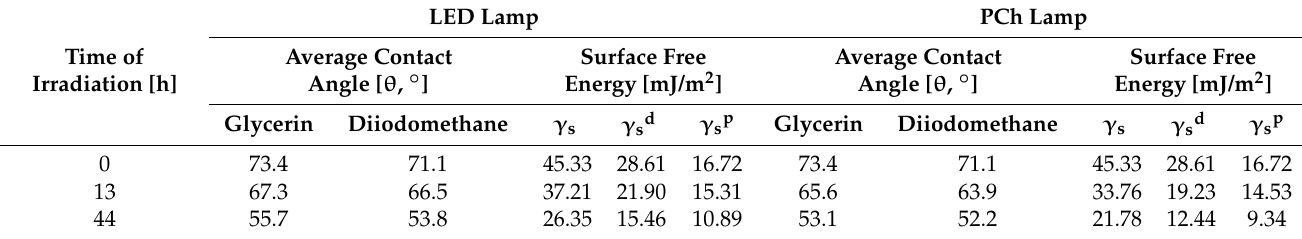
Table 2. Surface free energy for levan films before and after